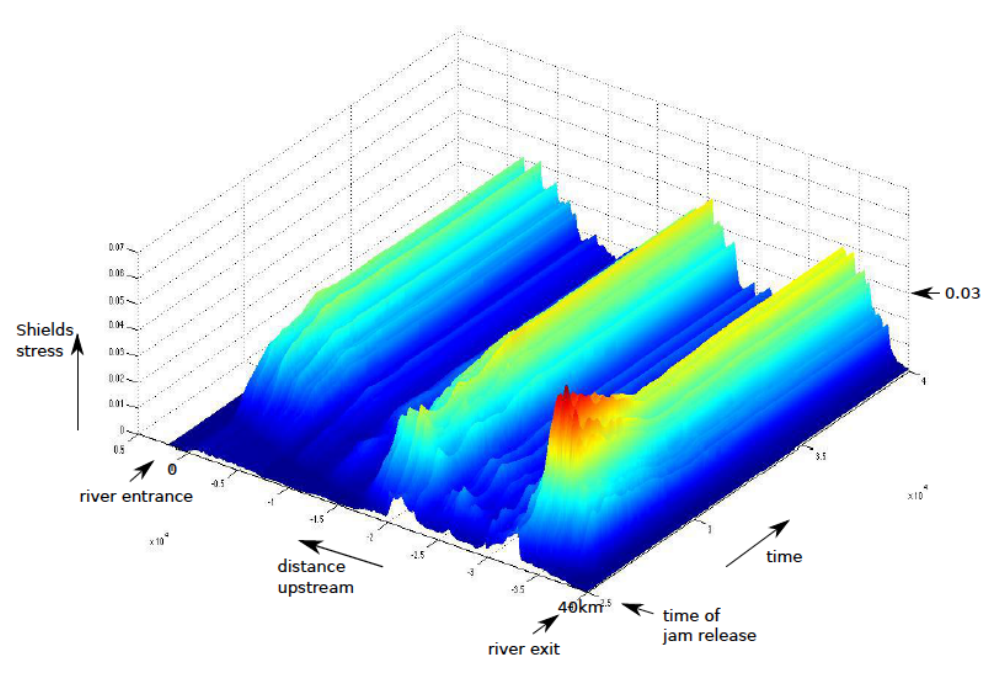
Figure 11. Evolution of stresses on the river bed following the release of a